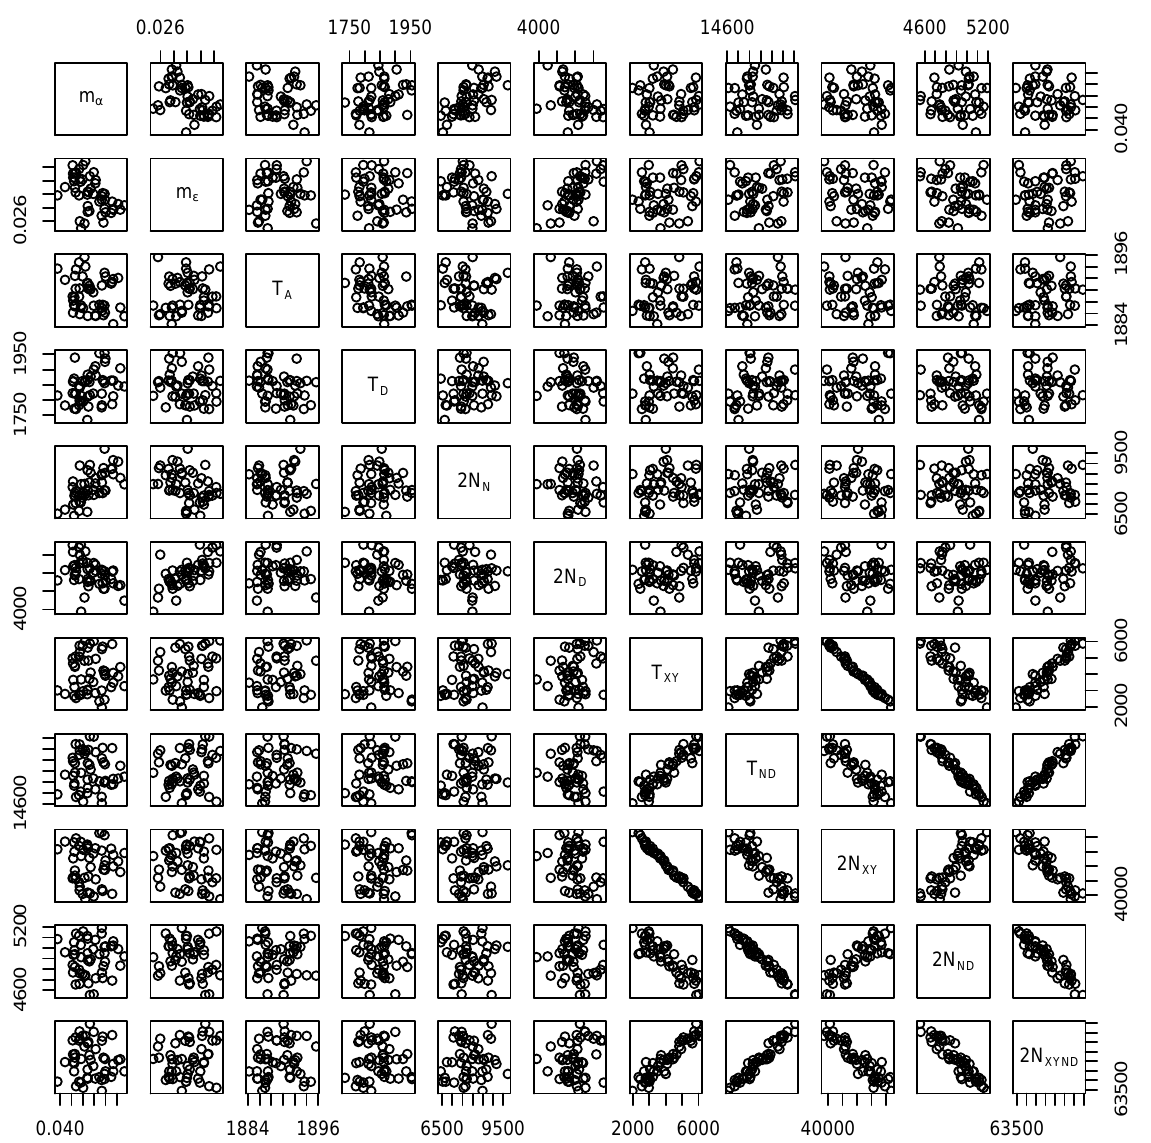
Figure 3 – Scatter plot of each parameter against each other, based on 50 simulated data